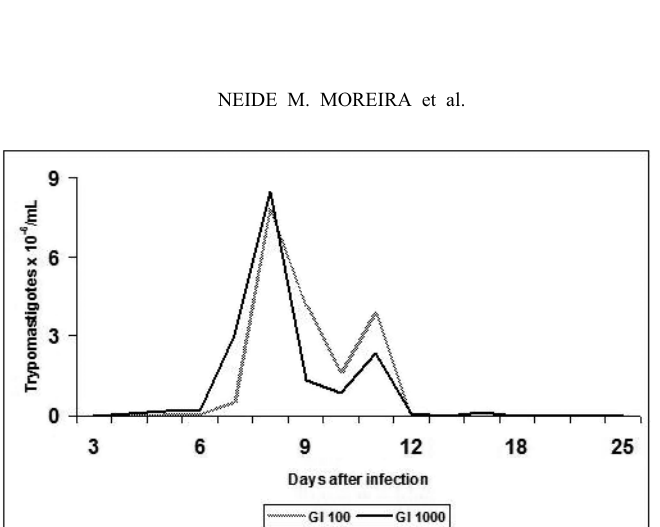
Fig. 1 – Curve of average parasitemia in 60-day-old Swiss male mice infected by the strain Y of T. cruzi . IG 100 – animals inoculated with 100 blood trypomastigotes, IG 1000 – animals inoculated with 1000 forms of blood trypomastigotes.